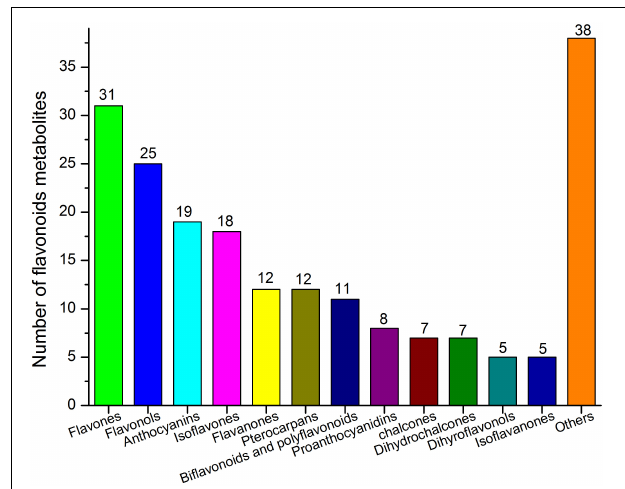
FIGURE 1 | Classification and statistical analysis of all detected flavonoids in all samples. The x -axis represents the different categories, and the y -axis represents the number of each